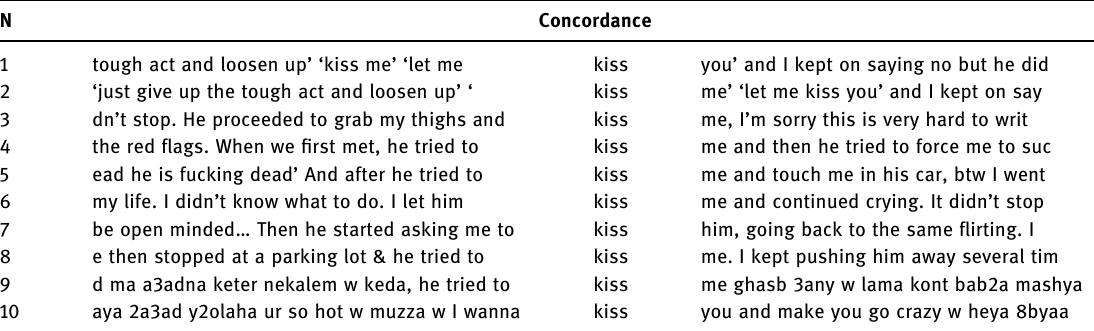
Table 29: Concordance lines for kiss N